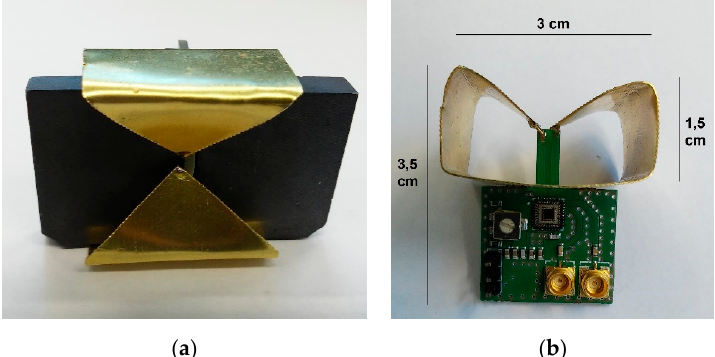
Figure 20. Mechanical setup of the proposed LCR antenna: ( a ) front view, ( b ) side view without ferrite absorber tiles.